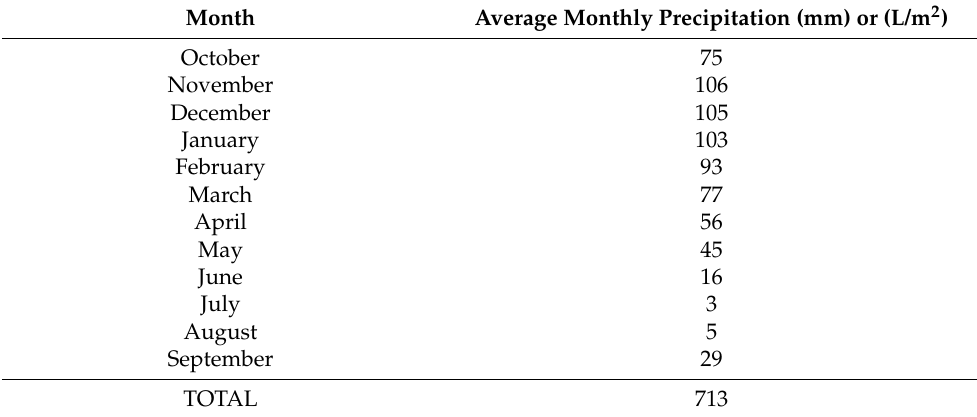
Table 1. Average monthly rainfall in Estoril (from the SNIRH website).